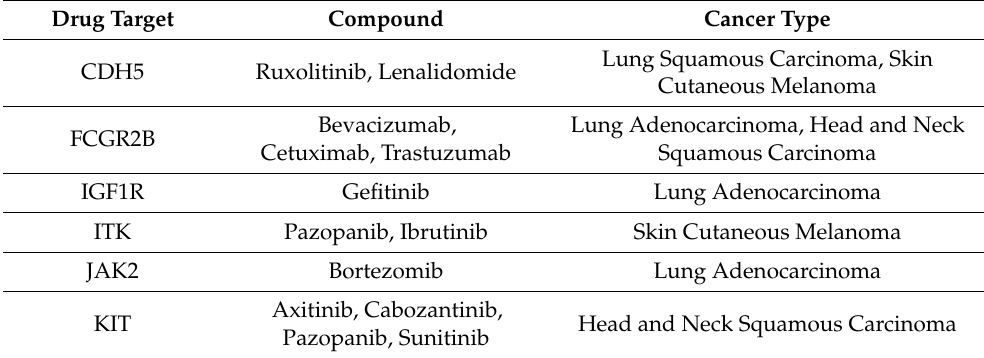
Table 3. Significant genes and potential compounds that can be used in immuno-targeted combina- tion